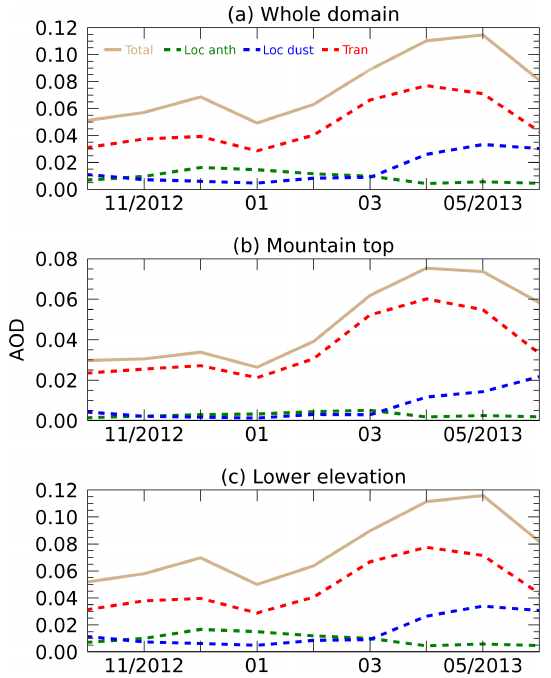
Figure 13. Monthly mean AOD simulated from CTRL for to- tal aerosols (brown solid), local anthropocentric aerosols (green dashed), local dust (blue dashed), and transported aerosols (red dashed) averaged over (a) the whole domain (34–42 ◦ N, 117– 124 ◦ W, not including ocean points), (b) mountaintops (with eleva- tion ≥ 2.5km), and (c) lower elevation area (<2.5km) from October 2012 to June 2013.